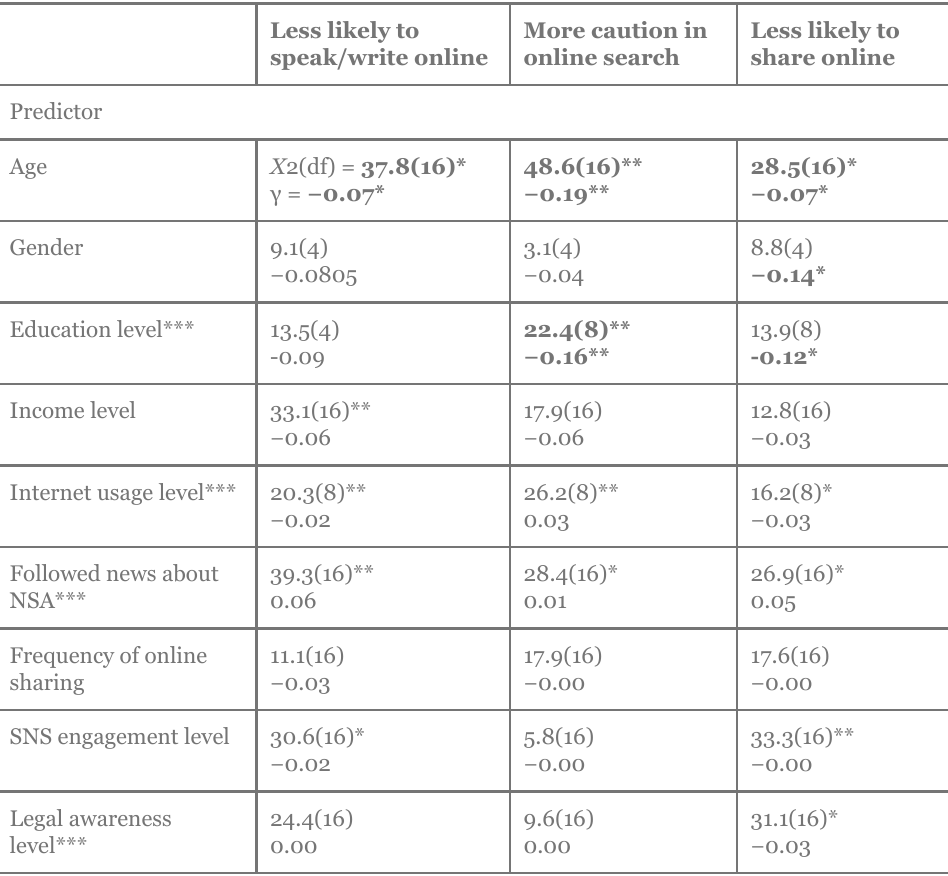
Table 1 − Anti-cyberbullying scenario (#1): chi-square ( Χ 2) and gamma (γ) test results predicting respondent’s willingness to discuss, search, or share content online after government enacts vague law criminalising cyber-bullying. Less likely to More caution in Less likely to speak/write online online search share online